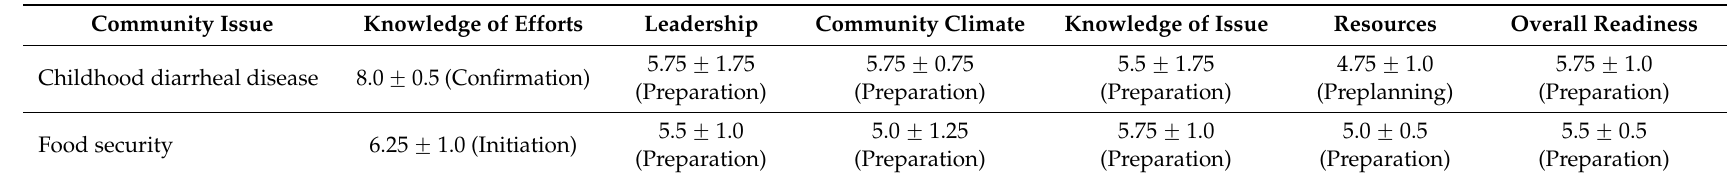
Table 2. Community readiness scores following analysis of individual interviews, were averaged for each dimension and the overall readiness score for reducing childhood diarrheal diseases and improving food security 1 .